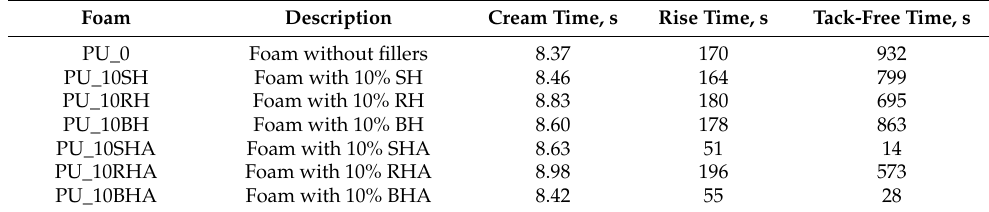
Table 2. Foaming parameters of polyurethane composites.